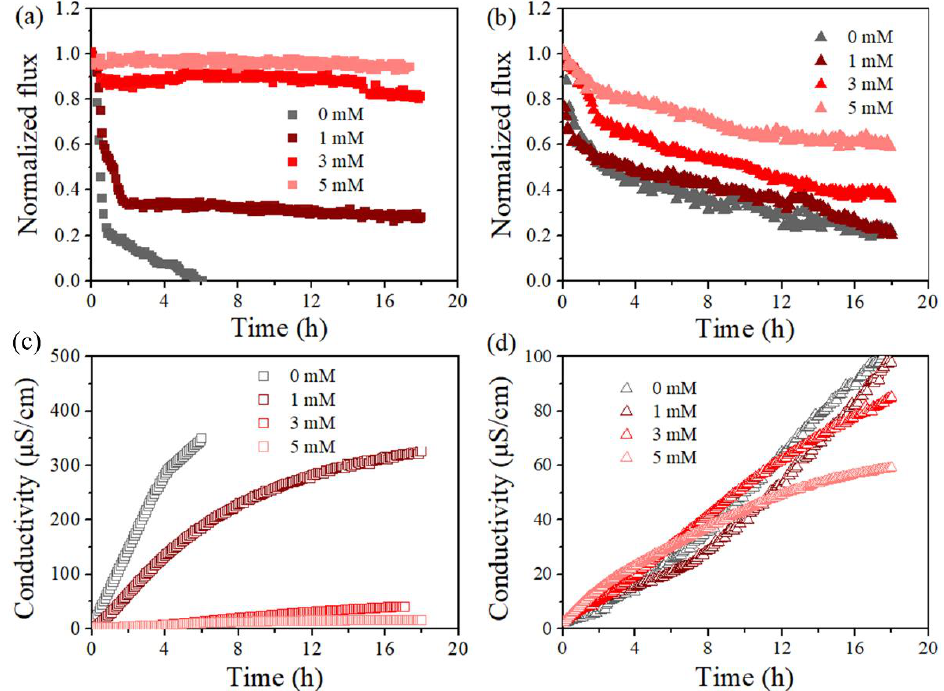
Figure 4. Effect of PDS concentrations (0, 1, 3, and 5 mM) on normalized, time-dependent permeability for PVDF ( a , c ) and PTFE ( b , d ) in the presence of 0.5 mM SDS ( a , c ) and 0.8 mM SDS ( b , d ), respectively. Normalization was on the basis of permeate flux for feed of 5 g/L NaCl in absence of SDS, which was 20.51 ± 1.81 kg/m 2 /h for PVDF, and 19.54 ± 1.52 kg/m 2 /h for PTFE at T f –T p = 50 °C, respectively.